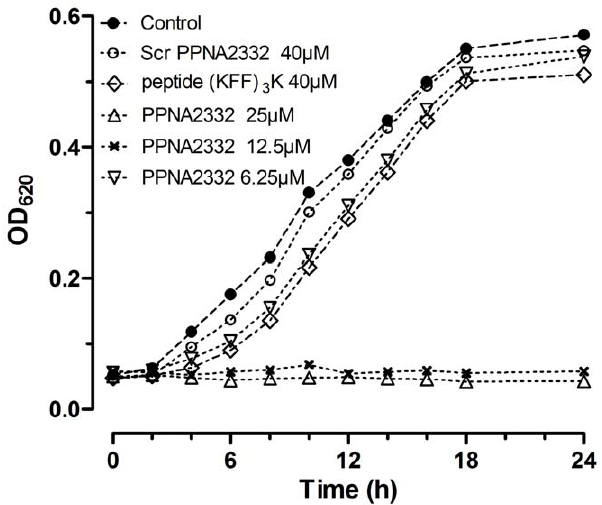
Figure 3. Bacteriocidal effects of anti- rpoD PPNA2332 on the viable cells of MRSA/VISA Mu50 in pure culture. Anti- rpoD PPNA2332 was added to cell cultures containing 1.0 6 10 5 CFU/mL MRSA/VISA Mu50 to a final concentration of 5, 10, 20, or 40 m M. Additional cell cultures were treated with free MH broth, scrambled PPNA2332 (final concentration of 40 m M), and peptide (KFF) 3 K (final concentration of 40 m M) in a volume equal to that of the PPNA2332 preparation as controls. Aliquots of each culture were collected at 0 h and 24 h, diluted, and inoculated onto solid MH agar. The number of CFU was calculated from the number of colonies growing on plates. The 24 h counts for 40 m M PPNA2332 were 0 CFUs/mL. The data are shown as means 6 SD for 2 samples from 2 independent test. *, P , 0.01 for comparison to control values.